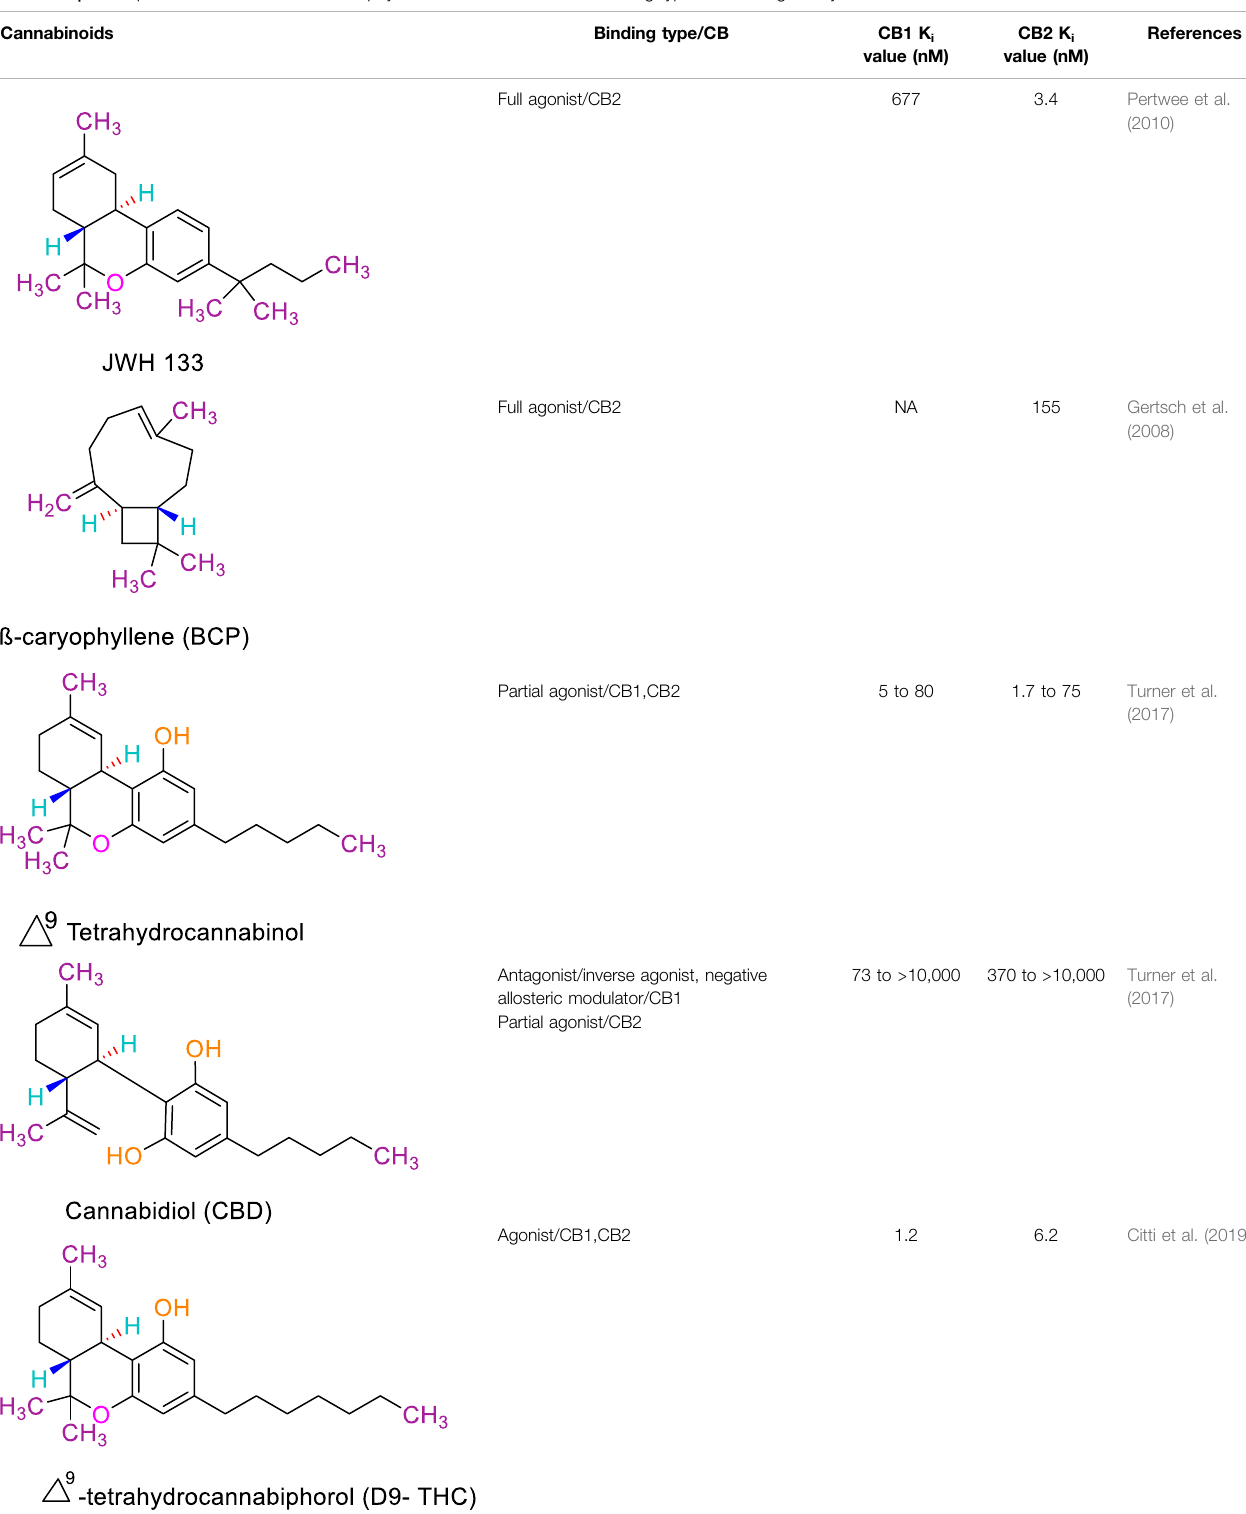
TABLE 1 | A comparision of JWH133 and main phytocannabinoids in terms of binding type and binding af fi nity.